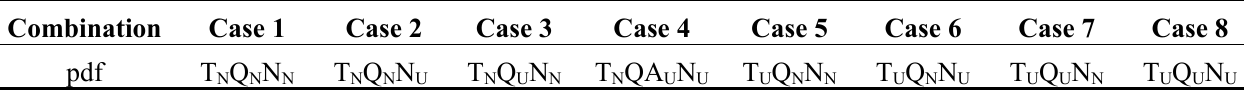
Table 1. Combinations of prior pdfs for model variables. The model variable is denoted by : A indicates a model variable, such as topography (T), discharge (Q) and Manning’s n A B (N); B means a prior pdf of a normal (N) and uniform (U)